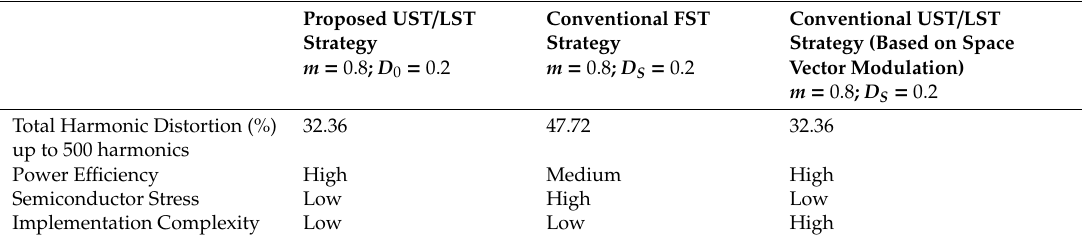
Table 3. Comparison of the new carried based UST / LST and the classical full shoot-through (FST) strategies.